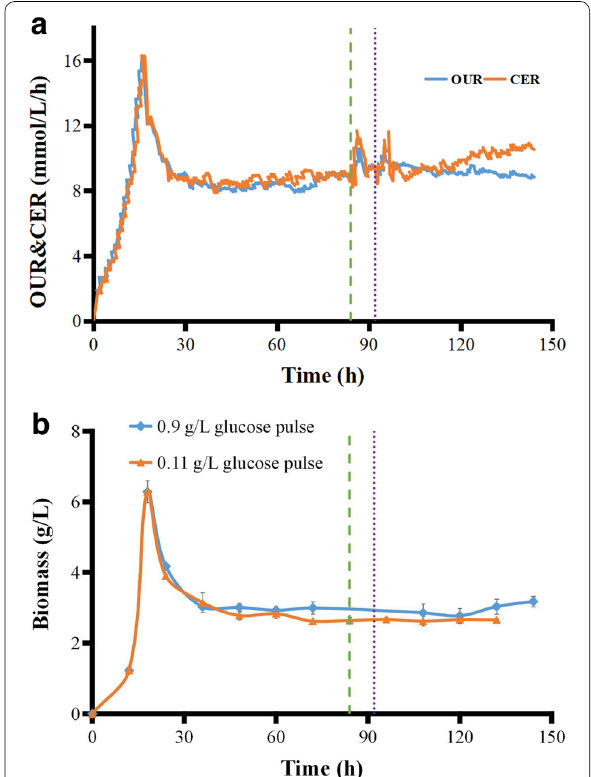
Fig. 1 a CER/OUR profiles over the course of the fermentation; b Biomass levels during the experiments. Closed lozenges are for the 0.90 g/L glucose pulse experiment and closed triangles for the 0.11 g/L glucose pulse experiment. The vertical hashed lines in the plot represent the timing of two glucose pulses, the first (green) one is for extracellular metabolites sampling and the second (purple) one for intracellular metabolites sampling